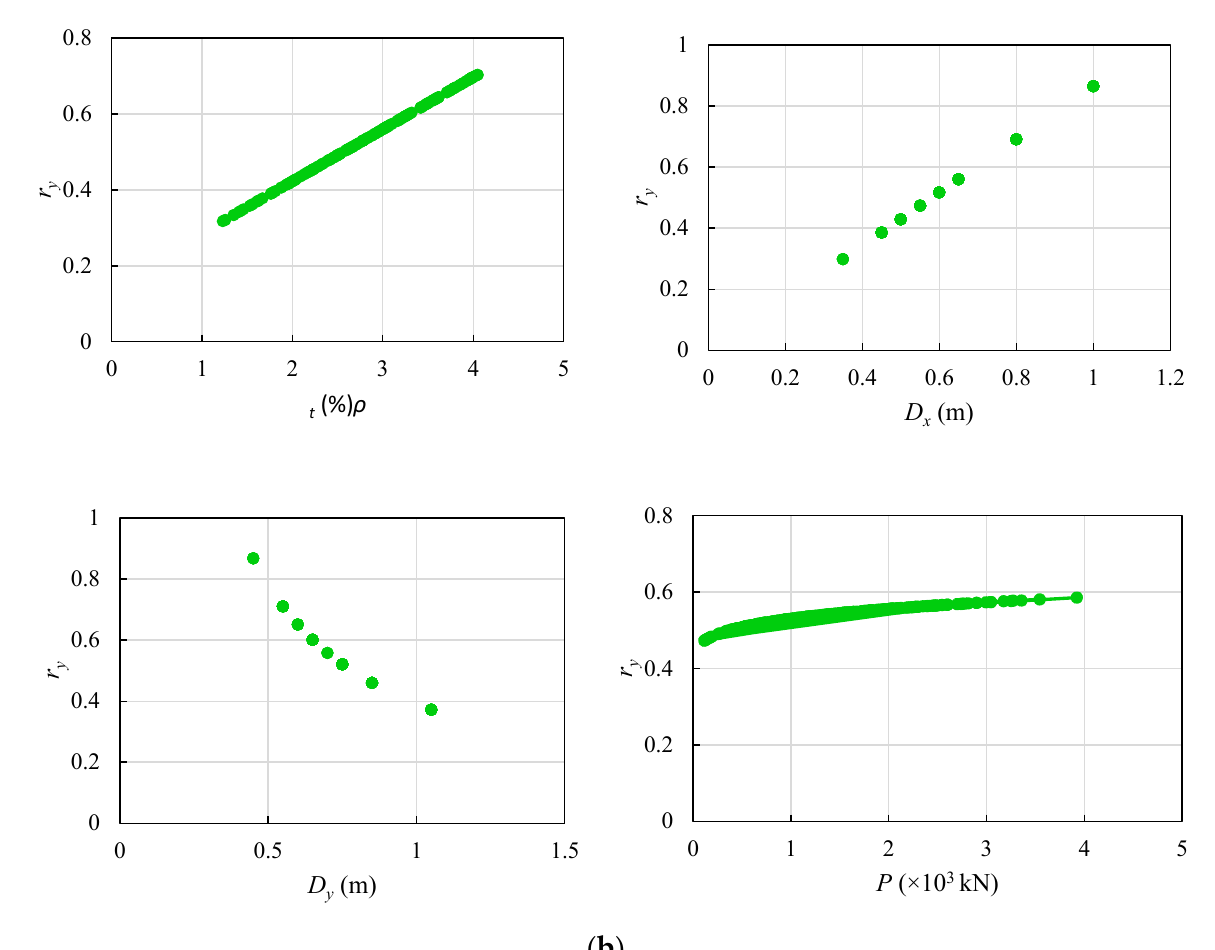
Figure 4. Effective stiffness ratio of RC column sections parametric analysis in the GEP ‐ based model; ( a ) r x ( b ) r y .